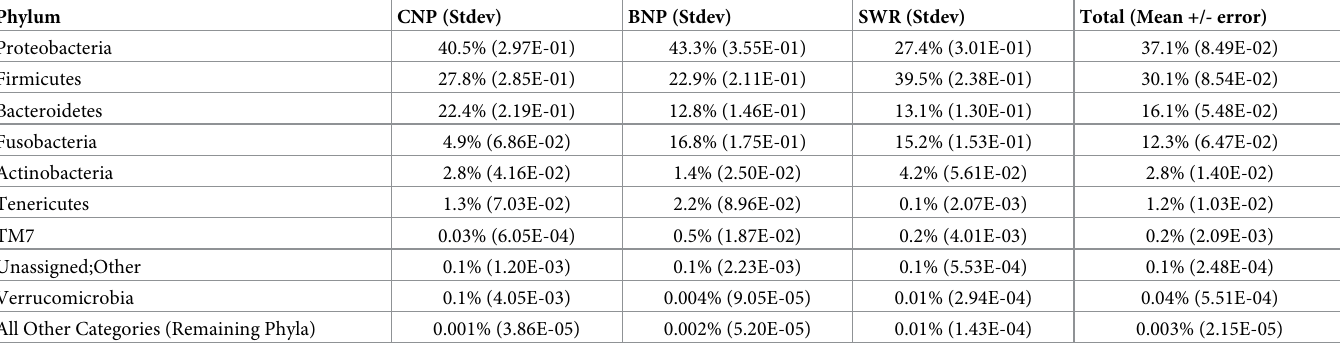
Table 1. Relative abundance of gut microbiota composition in Bengal tigers across three protected areas within TAL. The 10 most abundant bacterial phyla detected in tiger fecal samples collected across three major protected sites (CNP, BNP, SWR) within the Terai Arc Landscape of